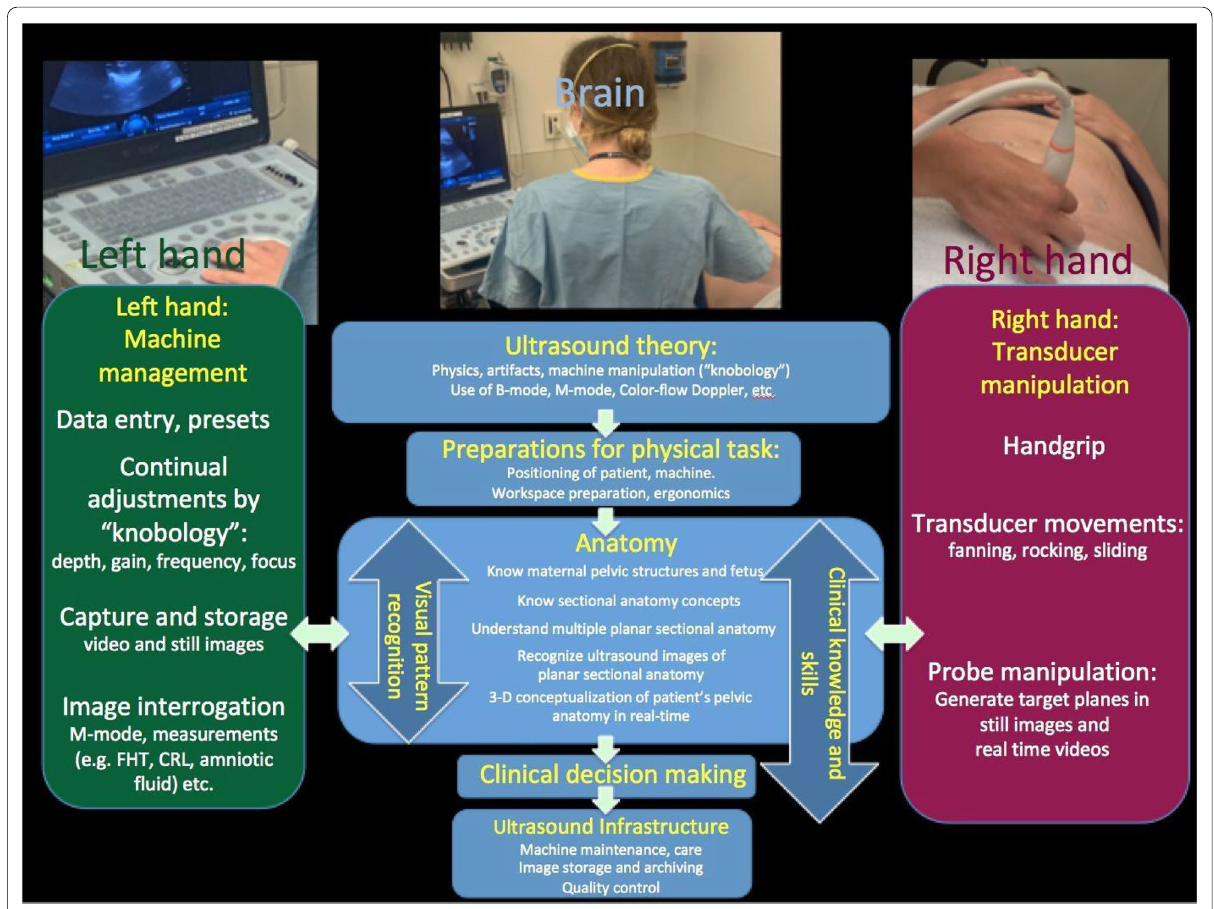
Fig. 3 Schematic representation of the psychomotor and cognitive processes that need to be mastered to scan effectively in real-time. The schematic envisions the trainee being observed from behind, operating the machine with the left hand, and with the transducer on the patient’s skin in his/her right hand. Some sonologists may choose to reverse this right/left arrangement (scanning images courtesy of Christy Moore,